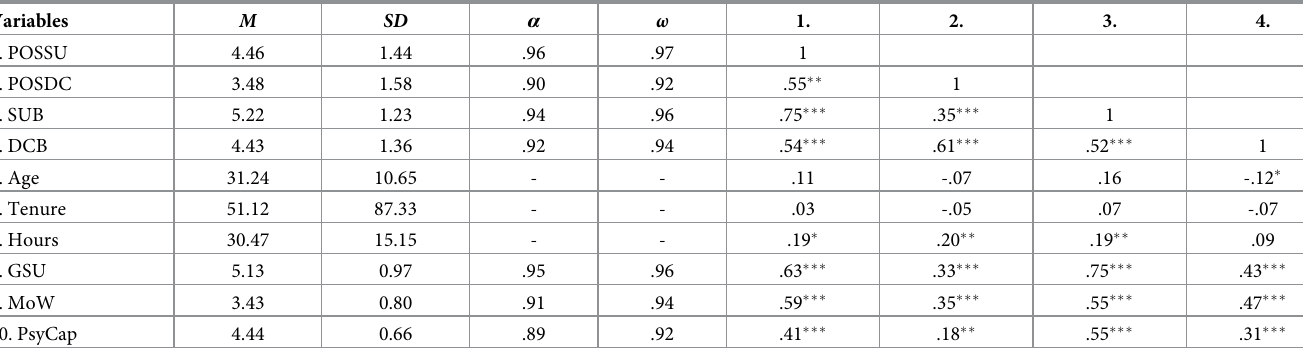
Table 5. Descriptive statistics and inter-correlations for Study 3 (N = 295). Variables